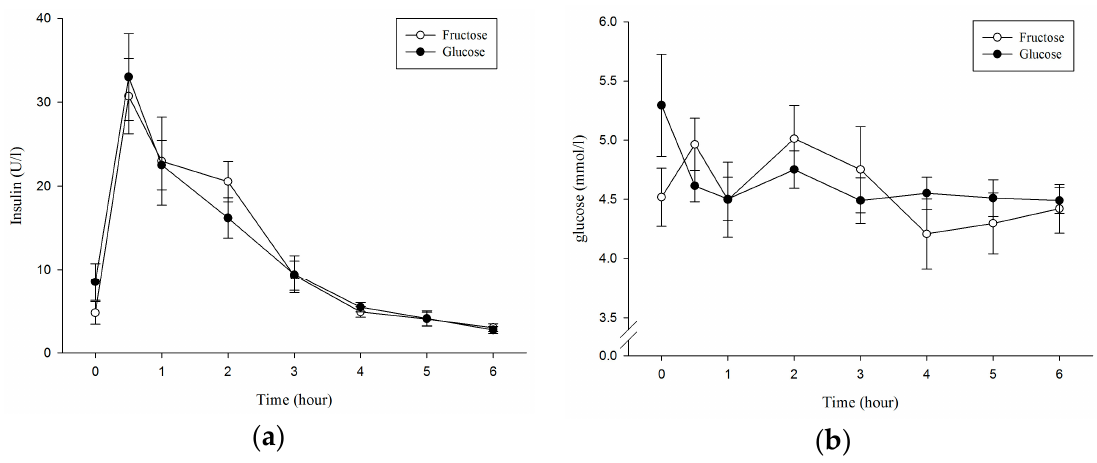
Figure 2. Serum insulin concentrations ( a ) and plasma glucose concentrations ( b ) during the 6 h postprandial period, p < 0.05. Table 1. The plasma and serum sample concentrations area under the curve.